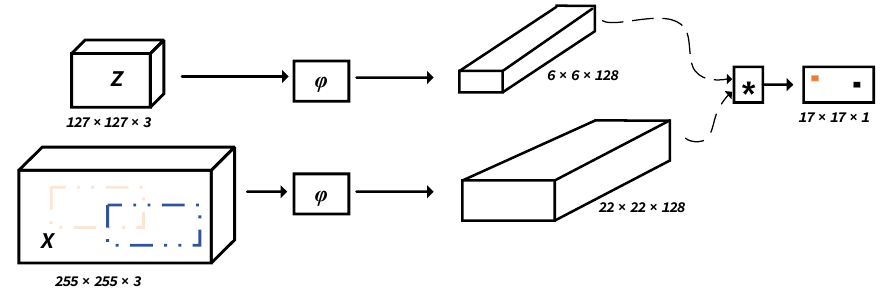
Figure 1. Fully convolutional Siamese architecture.